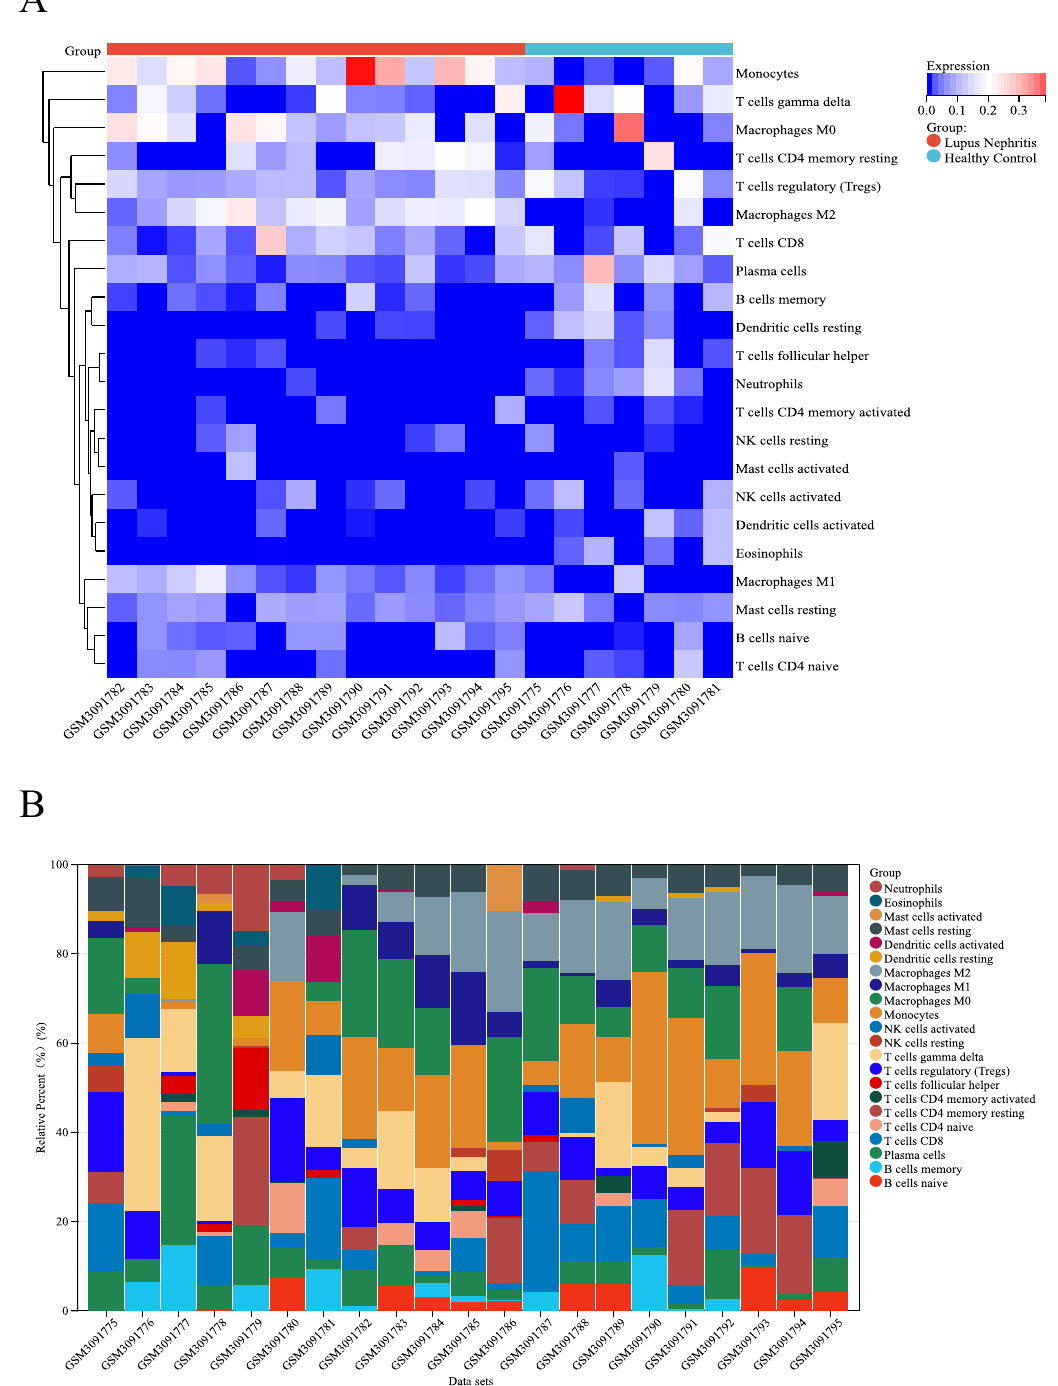
Figure 5. Infiltration of immune-associated cells in healthy and LN samples. ( A ) Immune cell content in each sample. ( B ) Relative percentage of 22 subpopulations of immune cells in 21 samples from the GSE112943